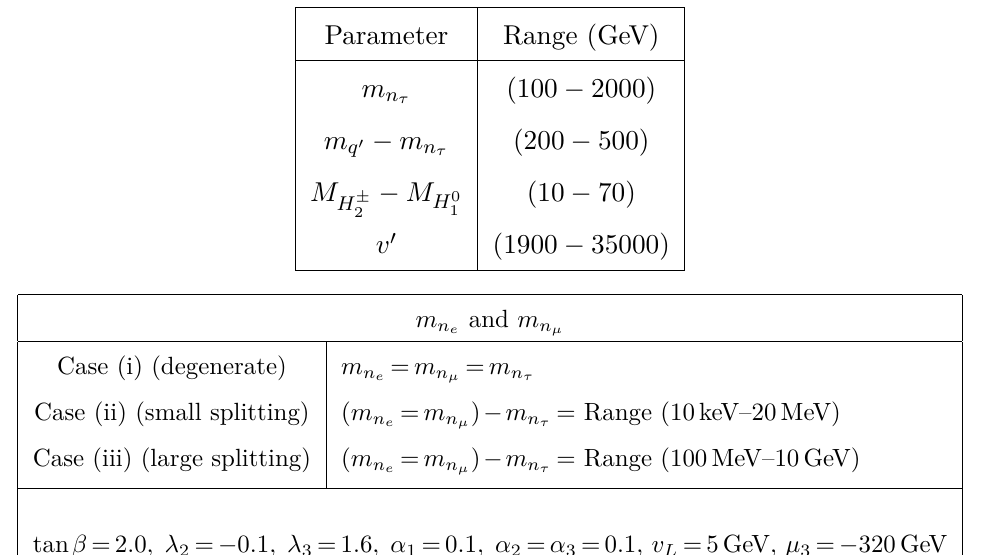
Table 4 . Annihilation channels for n τ . A specific channel will be available as long as the total mass of the final state is smaller than 2 m n